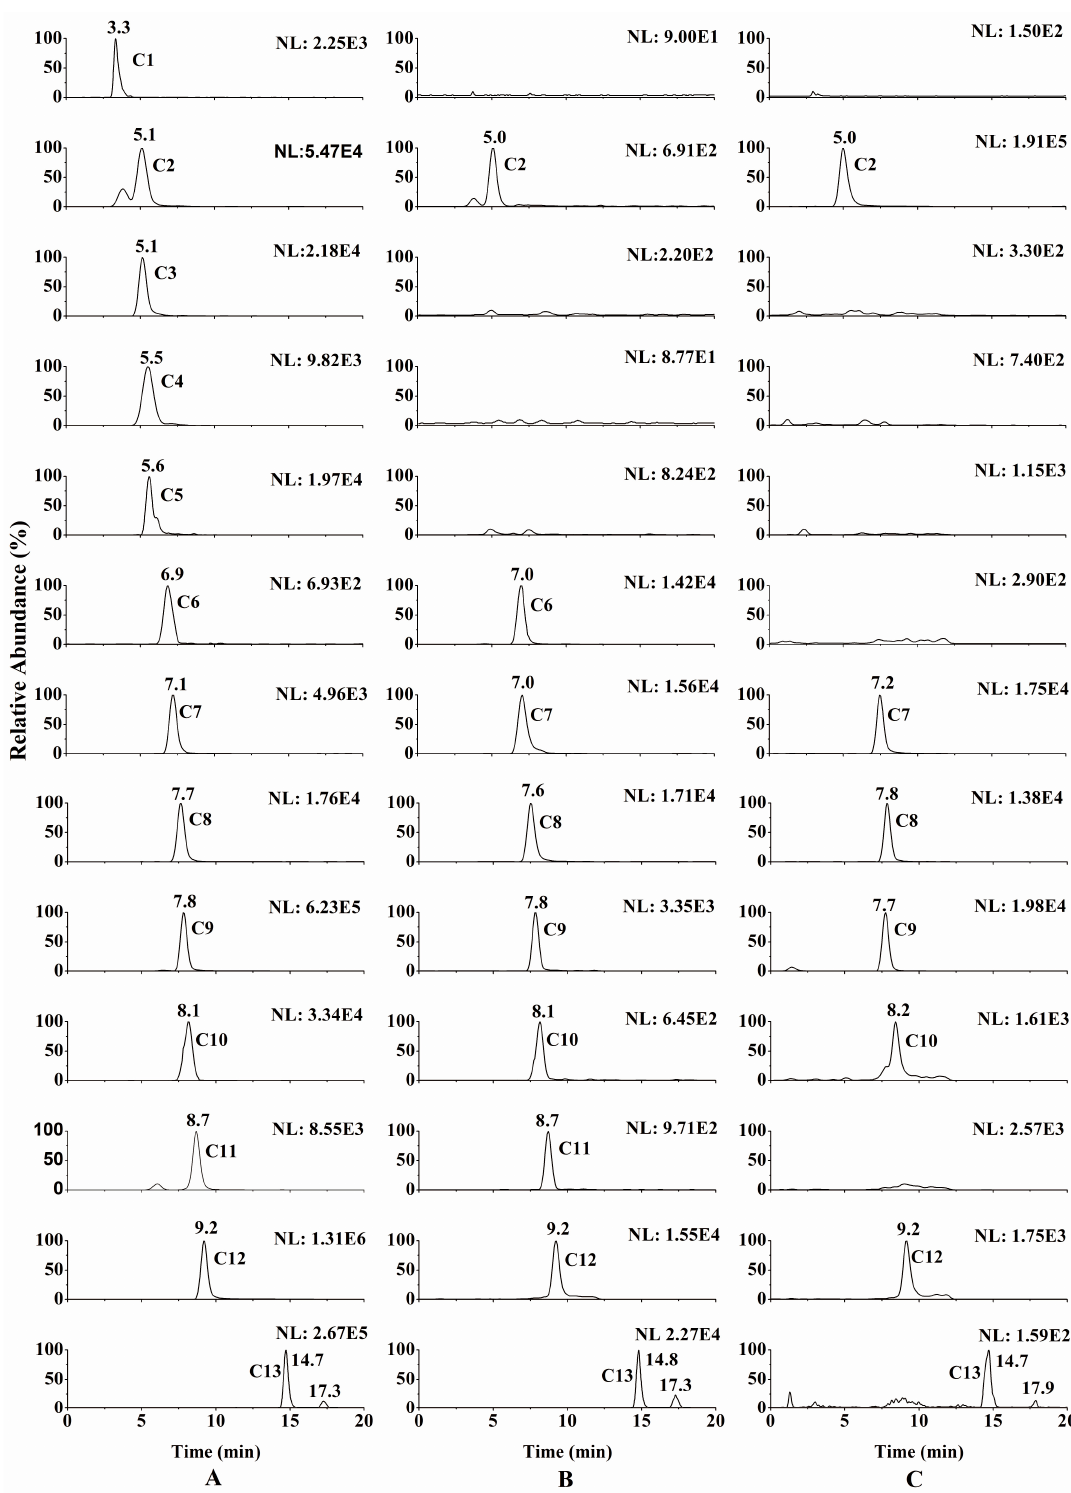
Figure 4. Typical full-scan product ion chromatograms of Jinlingzi San (JLZS) extract ( A ), reconstituted solution of decomposed BMLs ( B ), and real plasma sample at 1 h after JLZS administration ( C ).